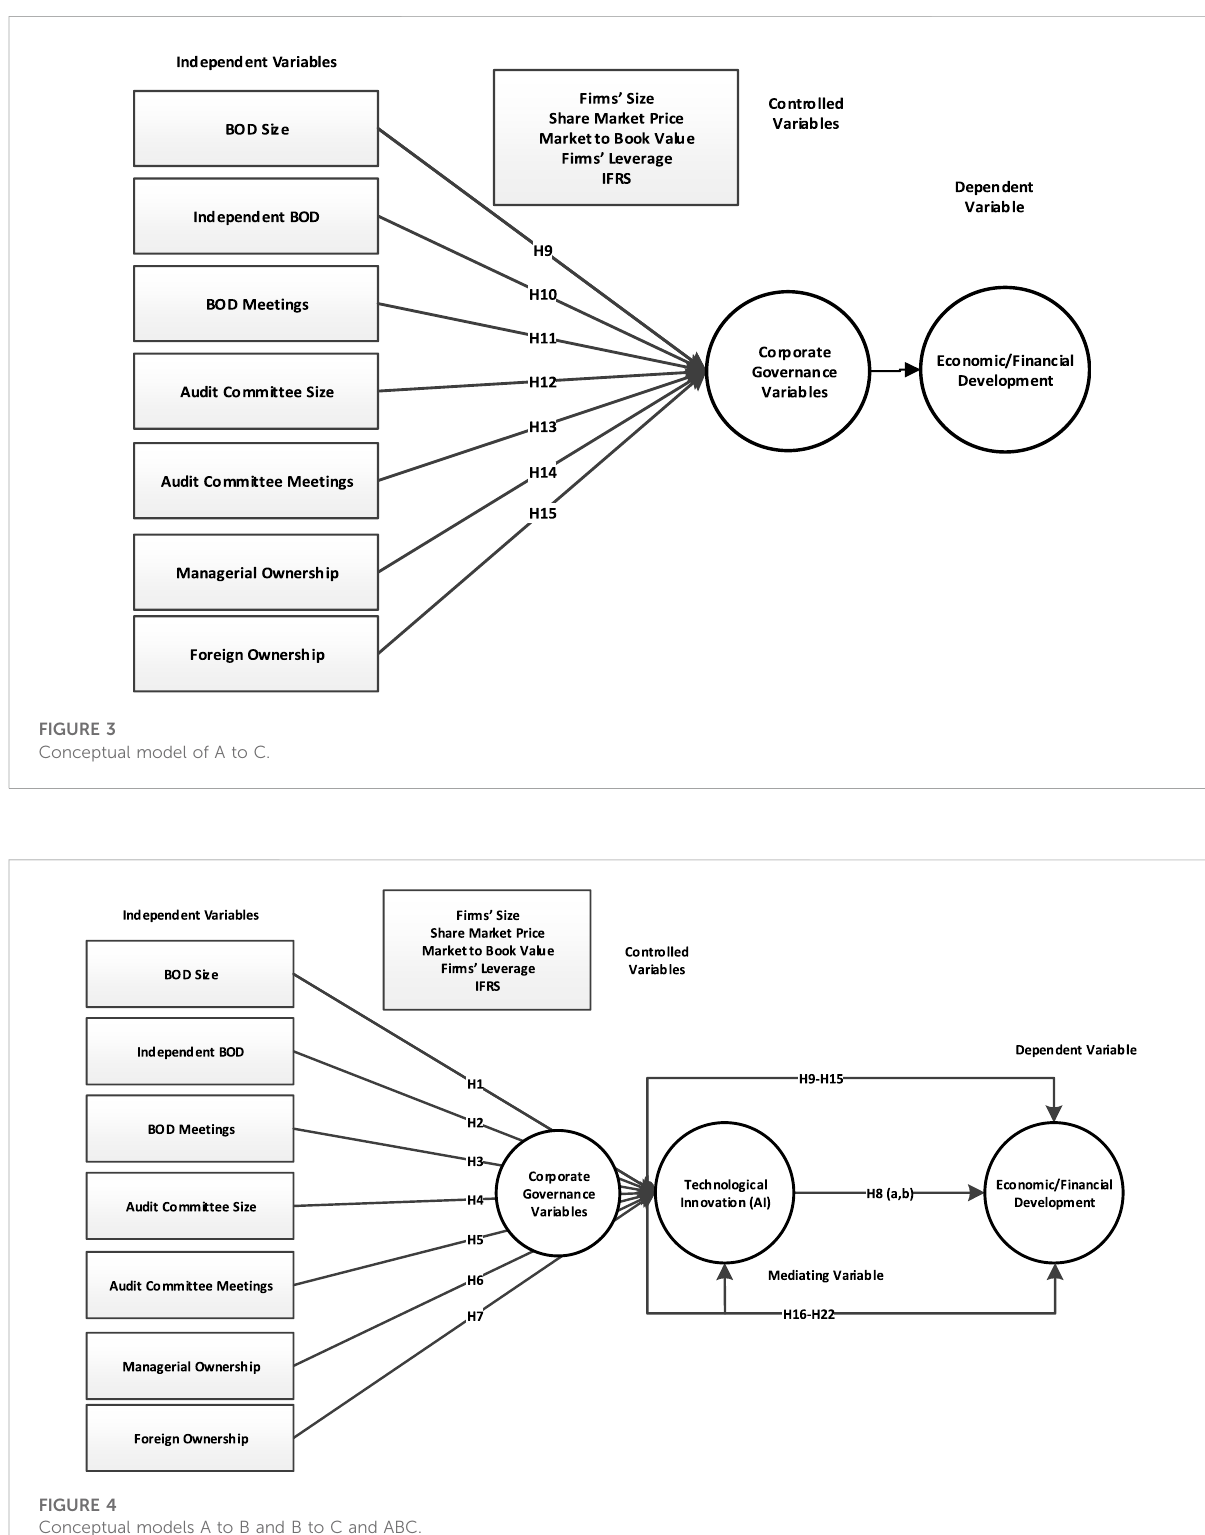
FIGURE 4 Conceptual models A to B and B to C and